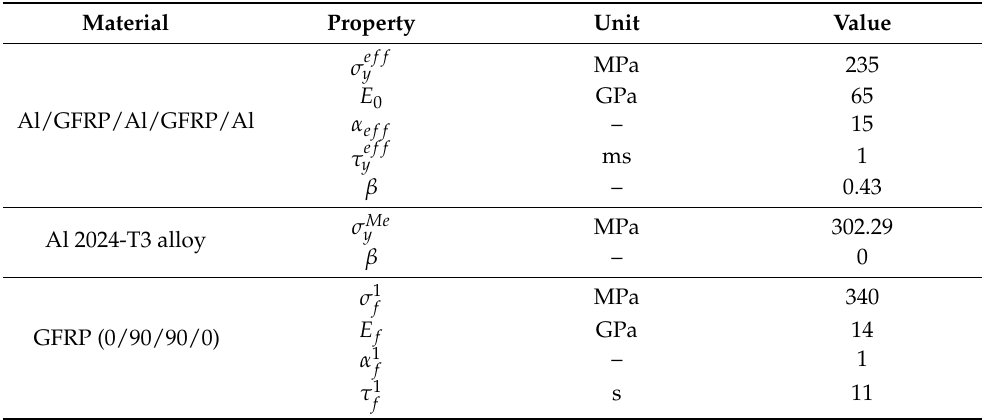
Table 2. Parameters of the model and materials [44] for the calculated deformation curves of the GLARE Al/GFRP/Al/GFRP/Al composite in Figure 2a.